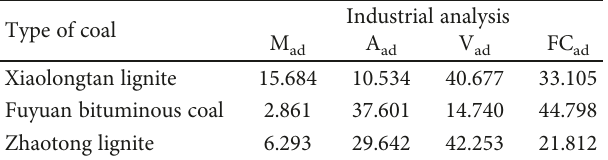
Table 1: Industrial analysis of coal samples. Type of coal